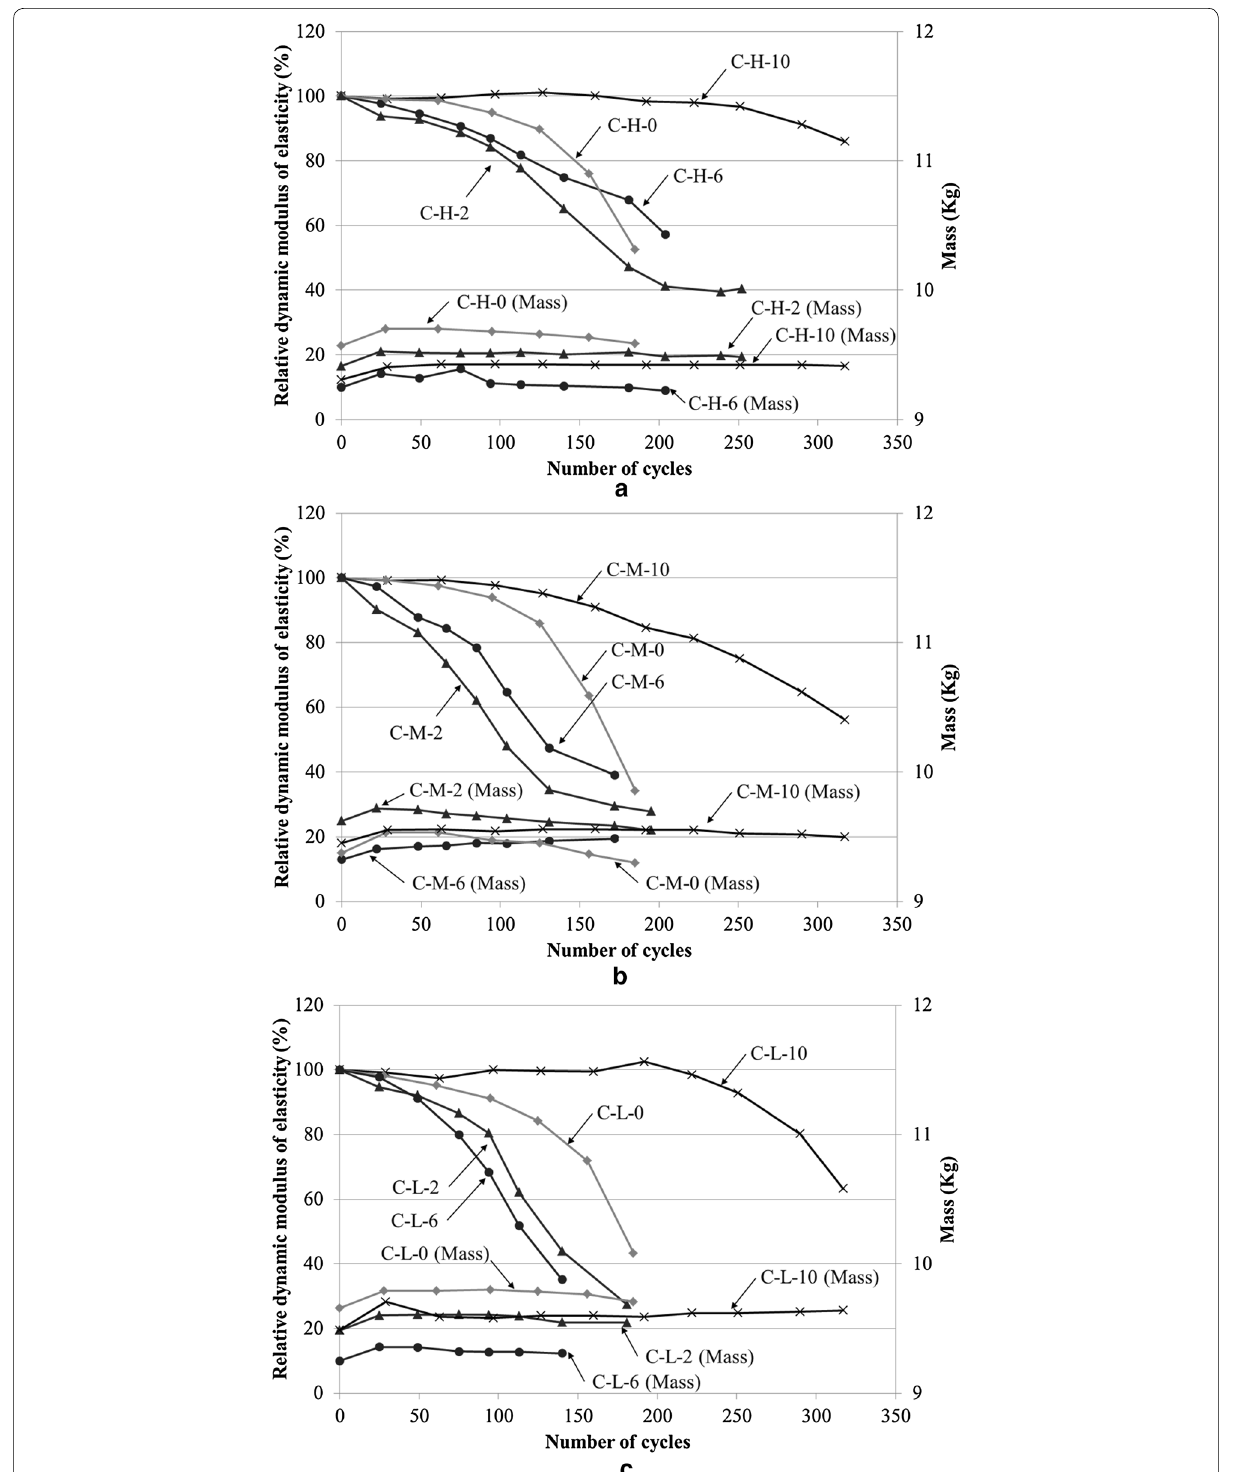
Fig. 20 Relative dynamic moduli of elasticity (RDMs) of concrete samples with a H-level, b M-level, and c L-level